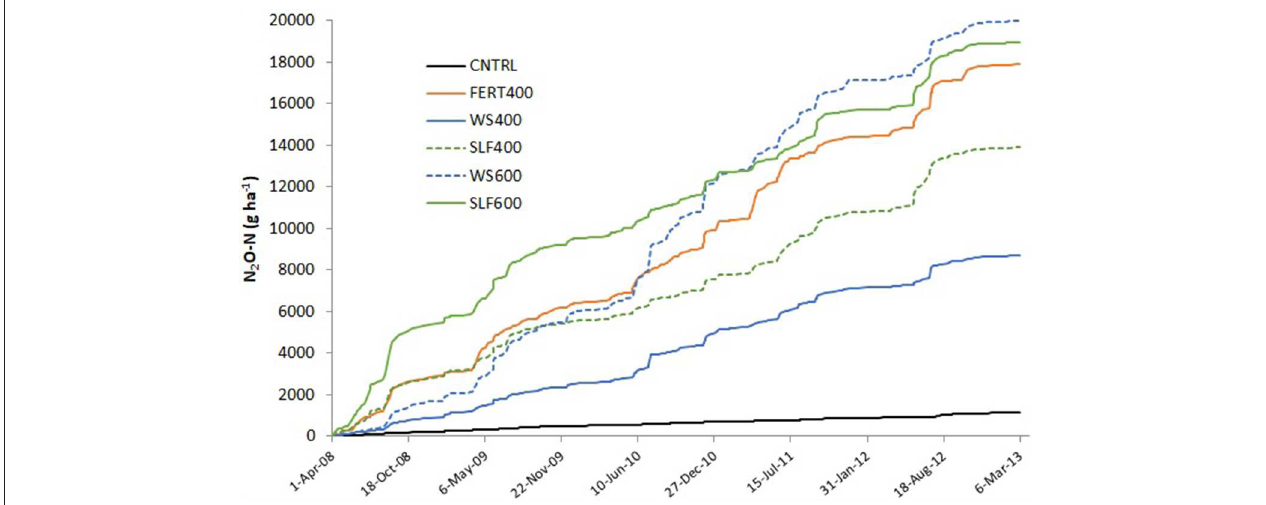
FIGURE 3 | Cumulative nitrous oxide emissions (N 2 O-N g ha − 1 ) between 10 April 2008 and 6 March 2013 ( ∼ 59 months) on replicated perennial grass plots treated with whole (WS) and separated liquid slurry (SLF), and mineral fertilizer (FERT) at contrasting rates of total-N and control (CTRL). Dashed line treatments received similar rates of